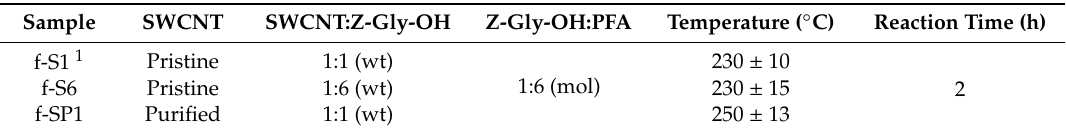
Table 1. Compositions of single walled carbon nanotubes (SWCNT), N-benzyloxycarbonylglycine (Z-Gly-OH), and paraformaldehyde (PFA) used for the 1,3-dipolar cycloaddition reaction.